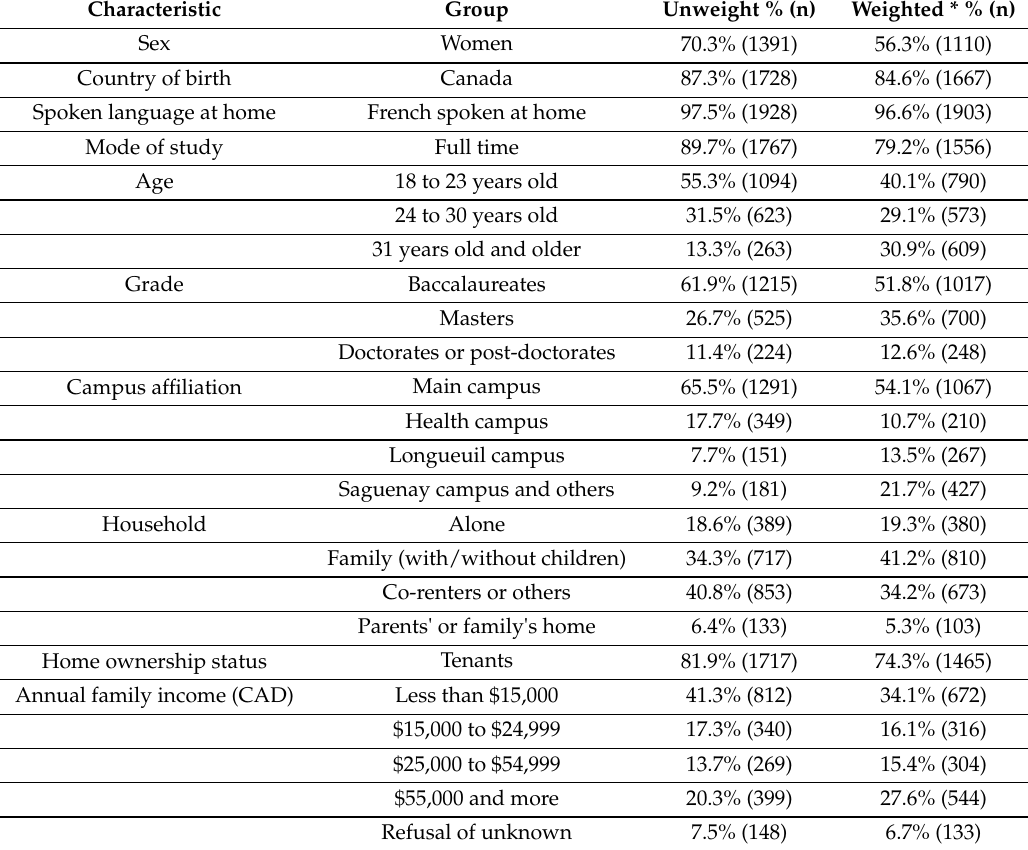
Table 1. Socio-demographic characteristics of respondents ( n = 2097), Université de Sherbrooke students (QC, Canada), winter